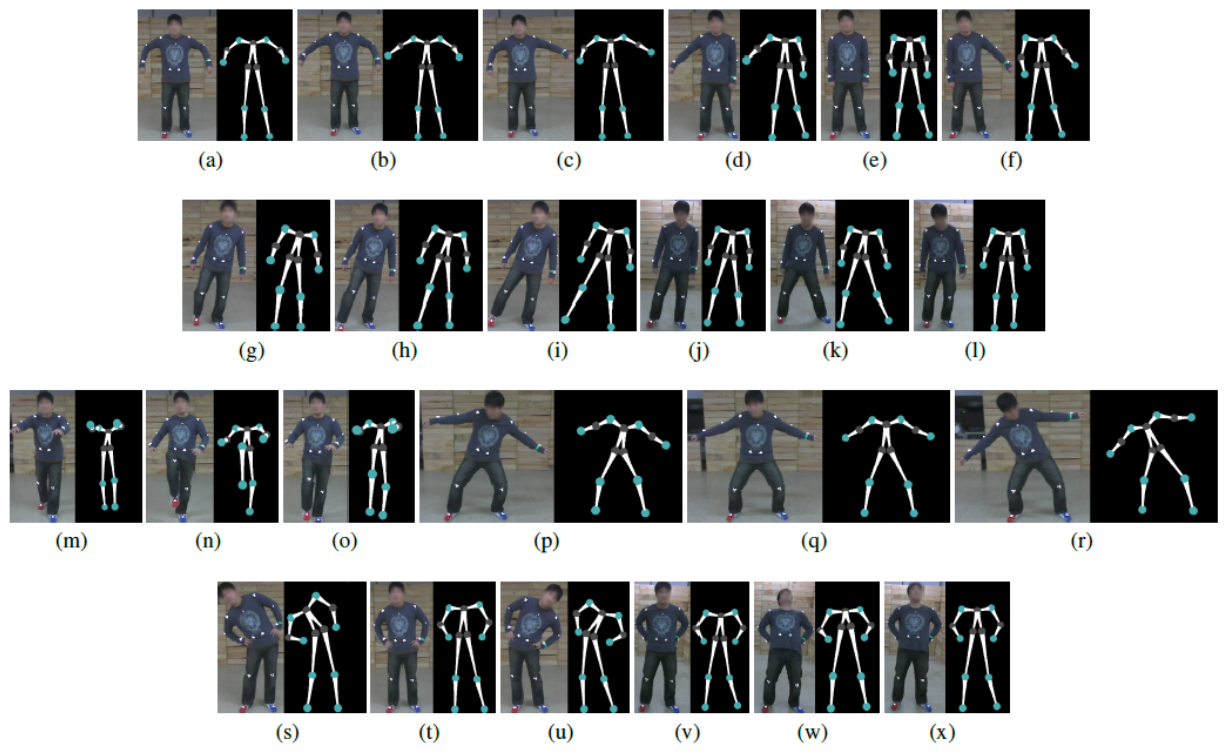
Figure 7. Examples of actions from the local human pose database. ( a )–( c ) Arm